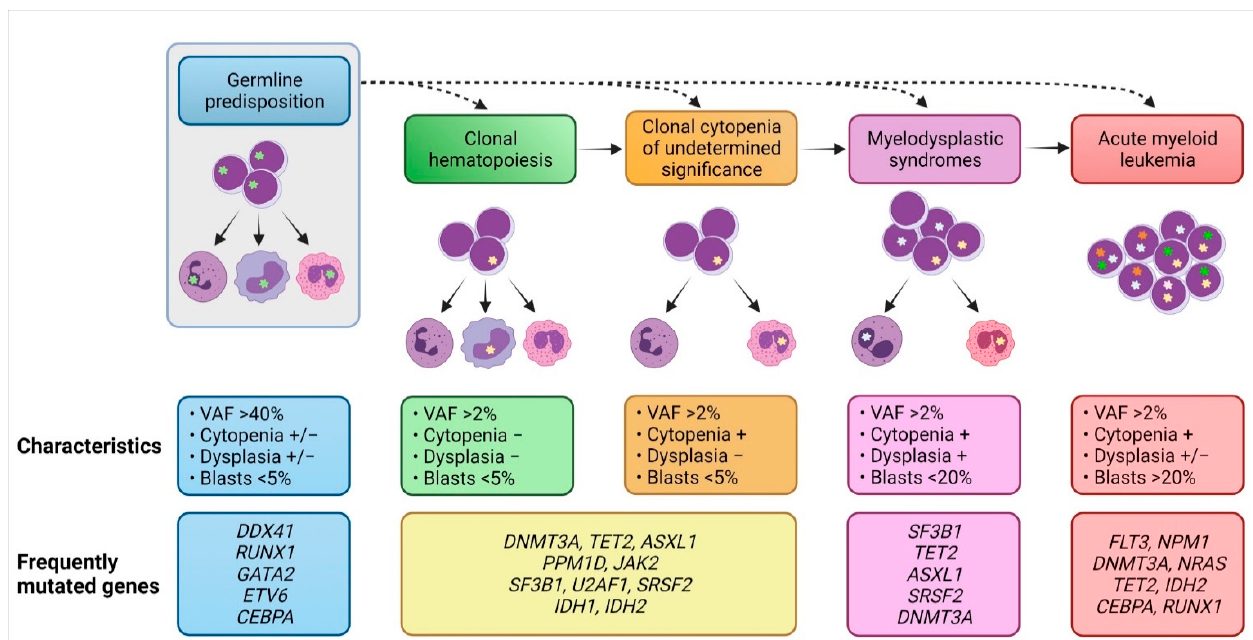
Figure 2. Evolution of myeloid malignancies from their antecedent precursor lesions. Germline mutations predispose individuals to acquire somatic mutations in their hematopoietic stem cells, leading to clonal hematopoiesis (CH) as well as clonal cytopenia of undetermined significance (CCUS). Both CH and CCUS are precursor conditions with increased risk for myelodysplastic syndrome (MDS) and acute myeloid leukemia (AML). Clinical characteristics, diagnostic criteria, and the most frequently affected genes are highlighted for each condition.